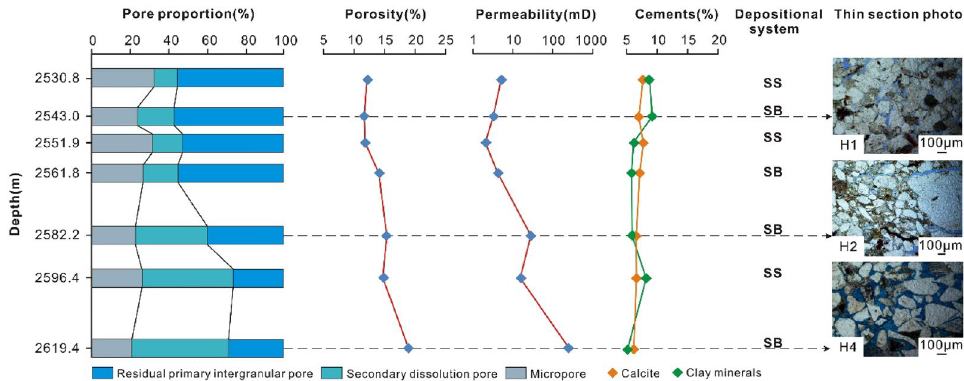
Figure 14. Tendency chart between pore proportion and porosity, permeability, cements and depositional systems of certain